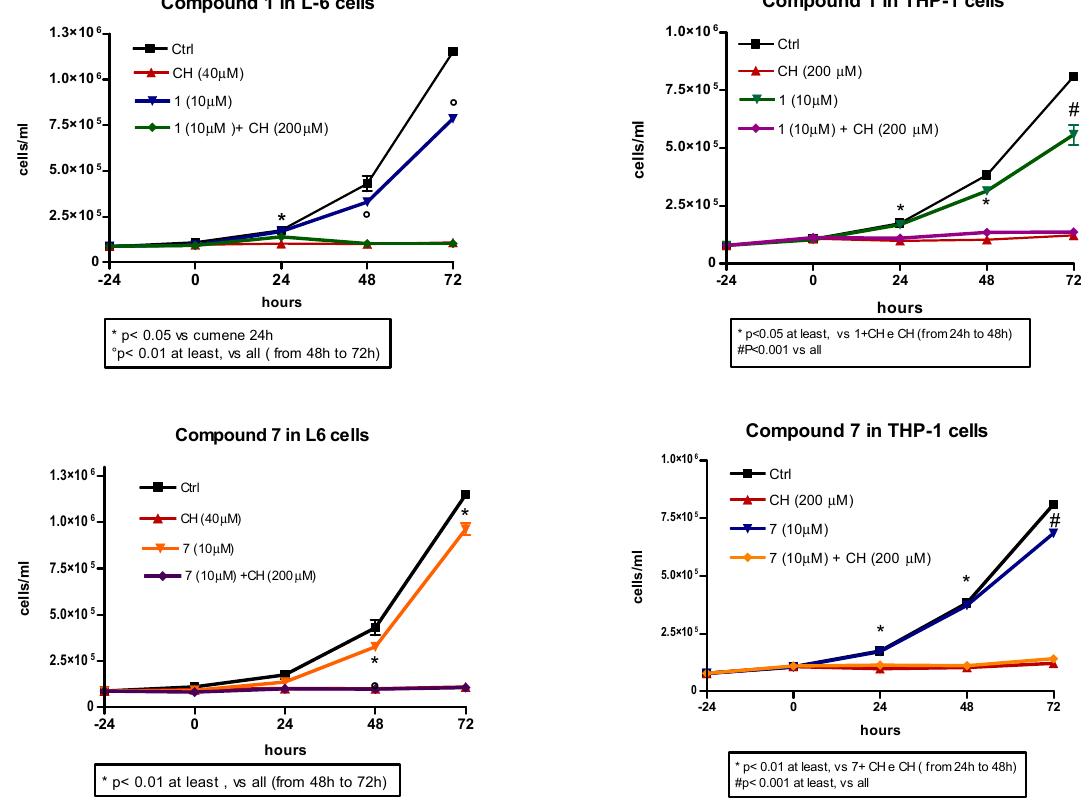
Figure 5. Effect of compound 1 and its ester 7 (10 µ M) on the proliferation of L6 and THP-1 cells in presence or absence of cumene hydroperoxide (CH, 40 µ M in L6 and 200 µ M in THP-1 cells). Cell counting was done with a Neubauer chamber. Data are reported as mean values ± SD of each compound tested in duplicate. Statistical analysis performed with one-way ANOVA and Bonferroni post-test.